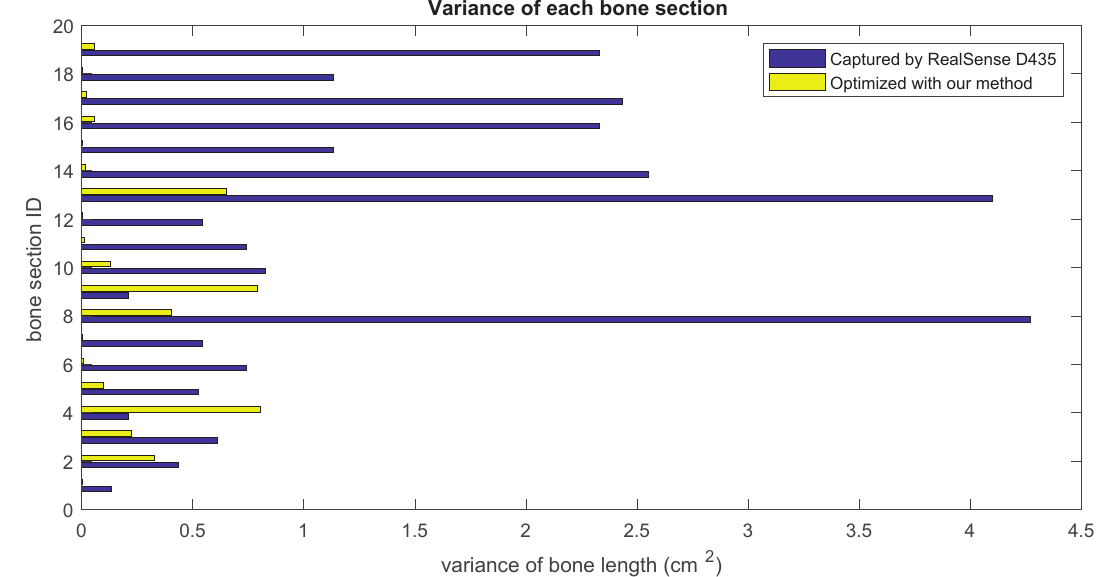
Figure 13. The summation of the bone length variance for each bone section over all frames. Purple: variance of the bone length captured with Nuitrack SDK for RealSense D435. Yellow: variance of the optimized bone length after applying our method.